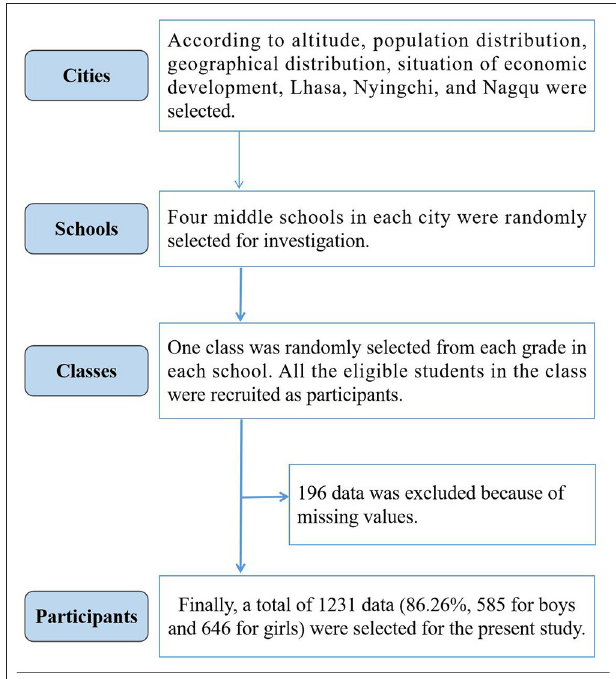
FIGURE 2 | Flowchart of participant inclusion for Chinese Tibetan adolescents.